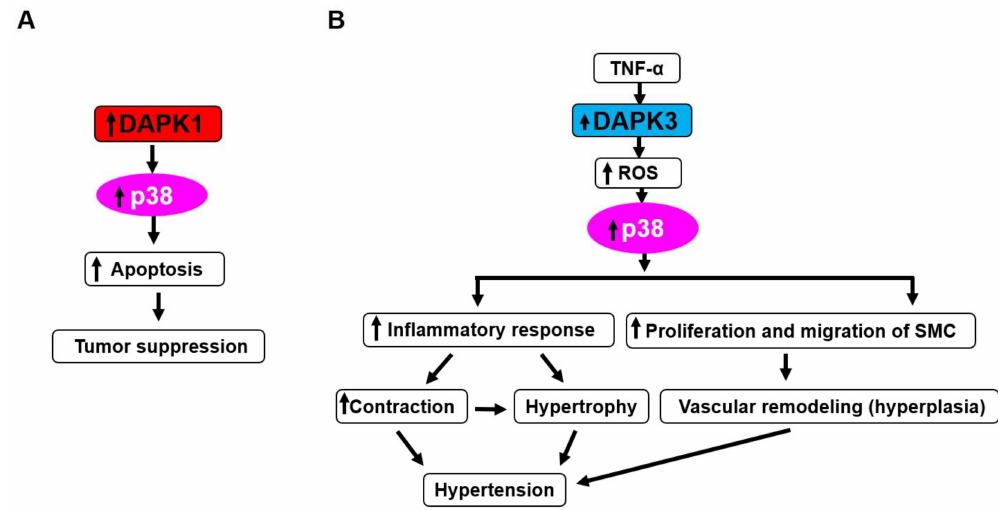
Figure 4. Interaction between DAPK proteins and p38. DAPK1-p38 plays a role in tumor suppression via promotion of apoptosis ( A ). DAPK3-p38 might mediate hypertension through increasing vascular contraction and hypertrophy via reactive oxygen species (ROS) generation and activation of p38-dependent inflammatory response ( B ). Besides, DAPK3 mediates vascular remodeling including hyperplasia through ROS generation, p38 activation, and promotion of proliferation and migration of SMC, which might lead to hypertension. Arrow indicates promotional effects.